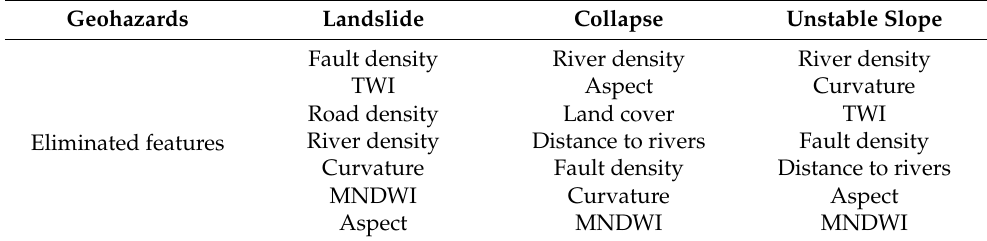
Table 12. Eliminated features in each dataset for final LSM, this table is in the order of feature importance. Features at the top are ones that were eliminated